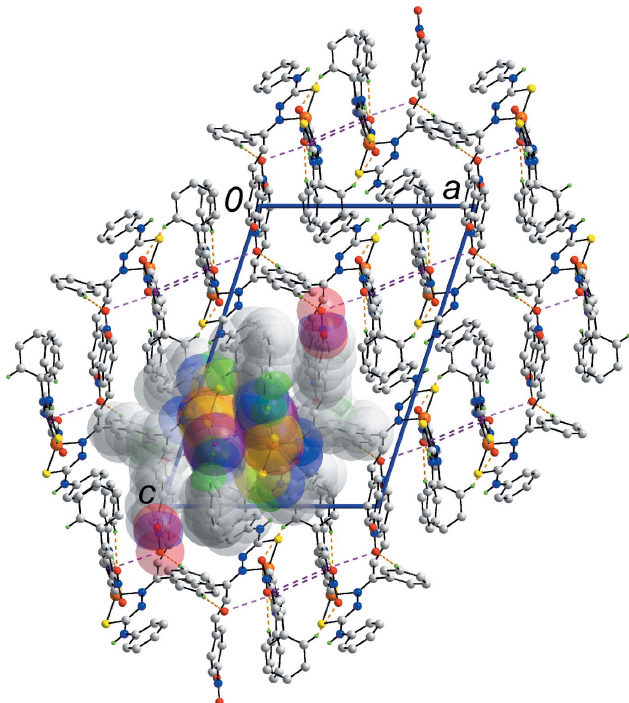
Figure 3 A view of the unit-cell contents shown in projection down the b -axis direction. The C—H (cid:3)(cid:3)(cid:3) O, N—O (cid:3)(cid:3)(cid:3) (cid:2) and (cid:2) – (cid:2) interactions are shown as orange, pink and purple dashed lines, respectively. The non-participating H atoms are omitted and one chain sustained by amine-N—H (cid:3)(cid:3)(cid:3) O(meth- O(methoxy), (cid:2) (phenyl)– (cid:2) (chelate ring) and phenyl-C—H (cid:3)(cid:3)(cid:3) O4(nitro) interactions is highlighted in space-filling mode.